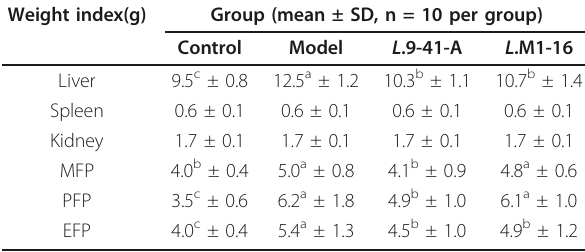
Control group: normal diet; model group: high-cholesterol diet; L .9-41-A group: high-cholesterol diet + L. plantarum 9-41-A; L .M1-16 group: high- cholesterol diet+ L. fermentum M1-16. MFP, mesenteric fat pad; PFP, perirenal fat pad; EFPs, epididymal fat pad The data are shown as the mean ± standard deviation a,b,c Mean values within a row with different superscript letters differ significantly (p < 0.05, n = 10).